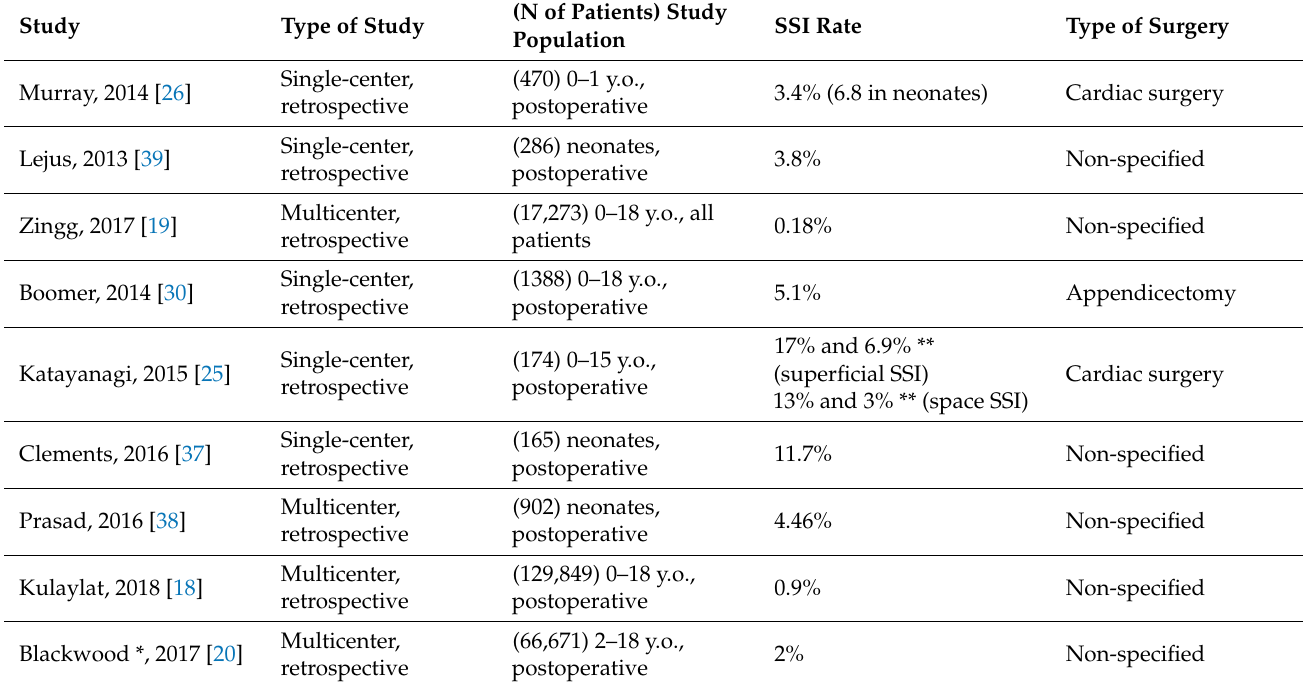
Table 1. SSI rates in children and